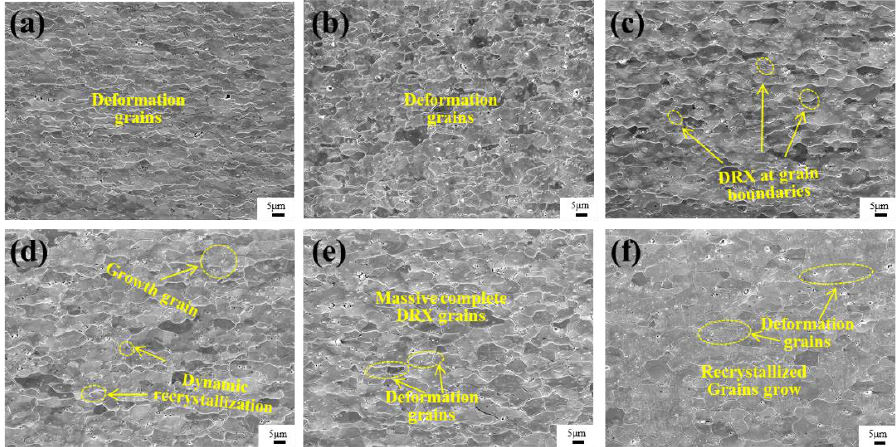
Figure 5. SEM images of Mo − 1.5wt% ZrO 2 alloy at a strain rate of 0.01 s −1 : ( a ) 1000 °C , ( b ) 1100 °C , ( c ) 1200 °C , ( d ) 1300 °C , ( e ) 1400 °C , ( f ) 1500 °C.